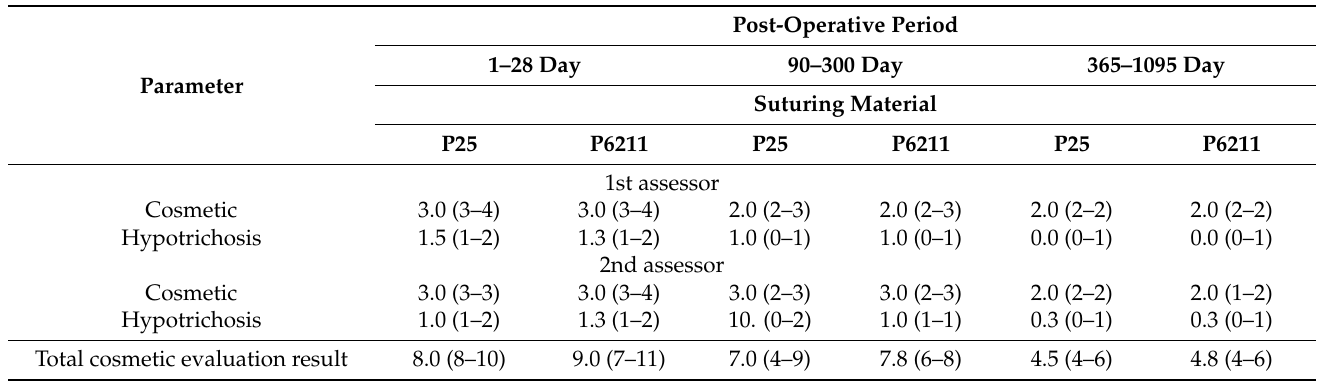
Table 1. Cosmetic scores for each suturing material, given by two different assessors and total cosmetic evaluation throughout the study (median values and interquartile length (in brackets)).